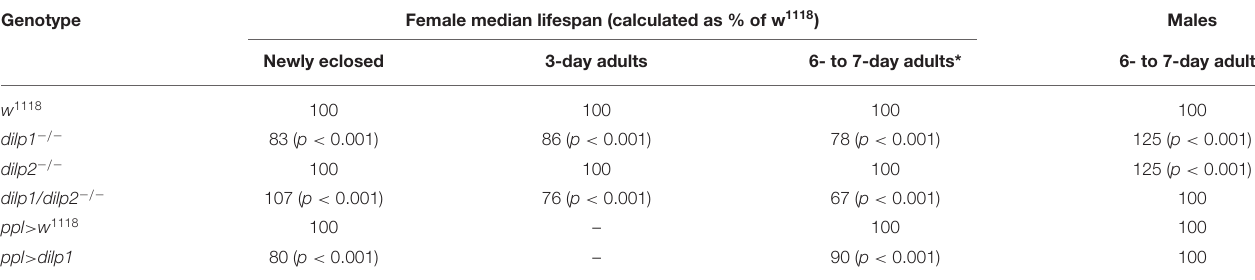
TABLE 2 | Median lifespans of dilp1 mutant and dilp1 overexpressing female and male flies exposed to starvation display a sex dimorphism.